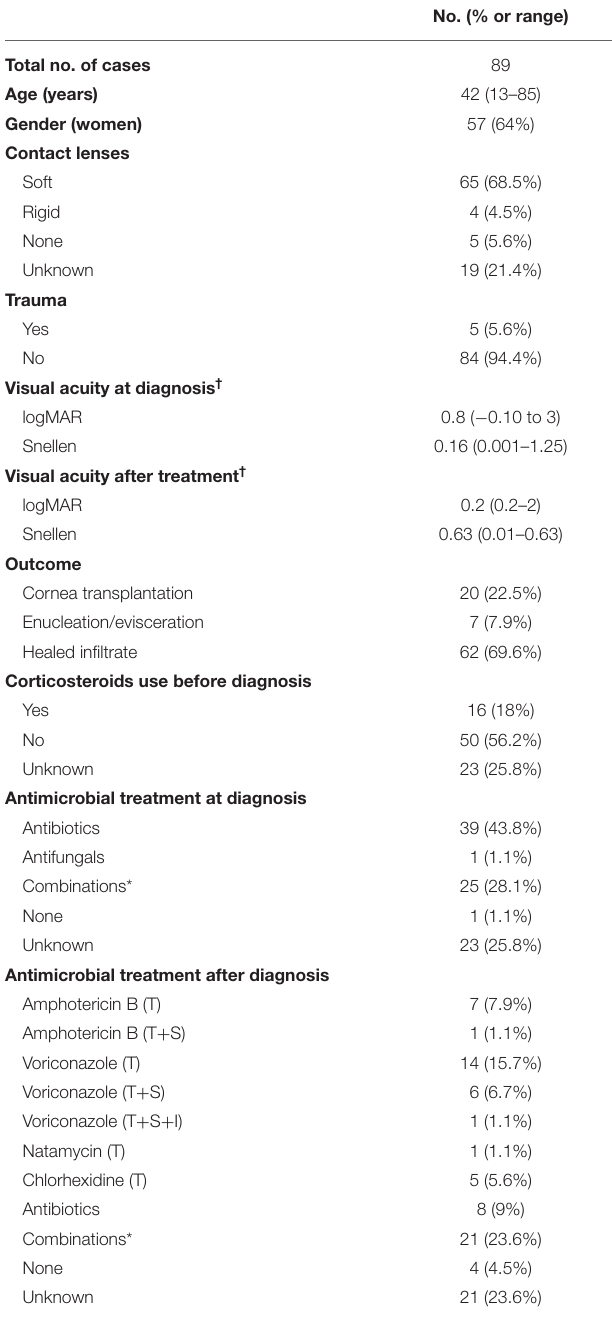
TABLE 1 | Clinical characteristics and outcome in Dutch patients with Fusarium keratitis.